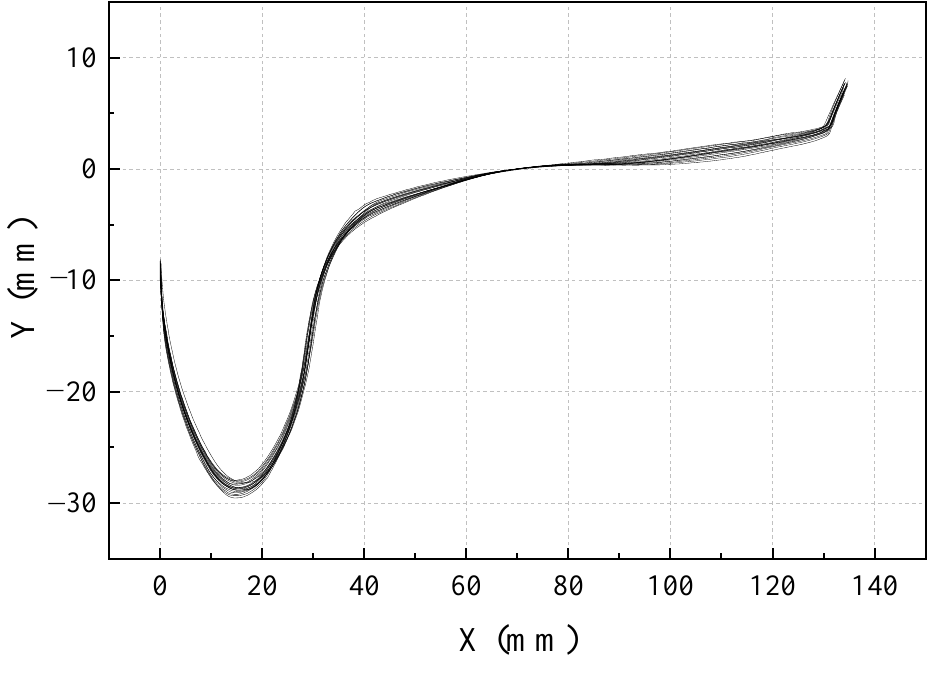
Figure 7. The wheel tread worn profile.